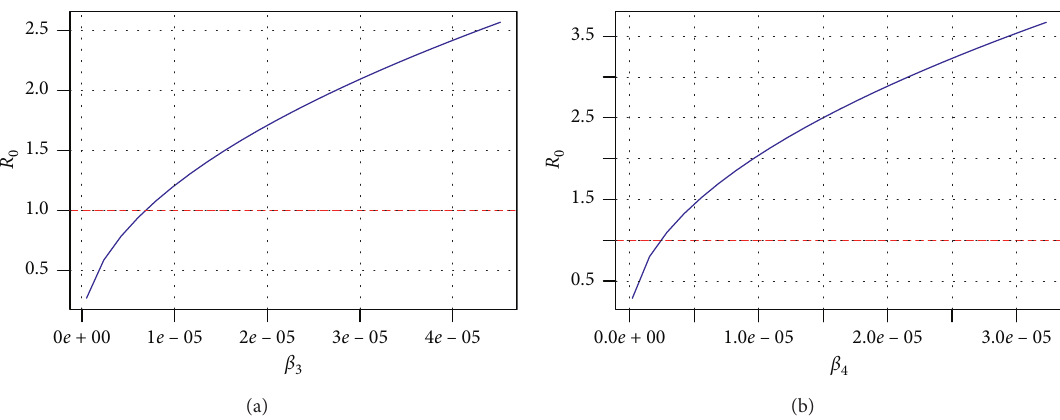
Figure 8: The influence of parameters on R